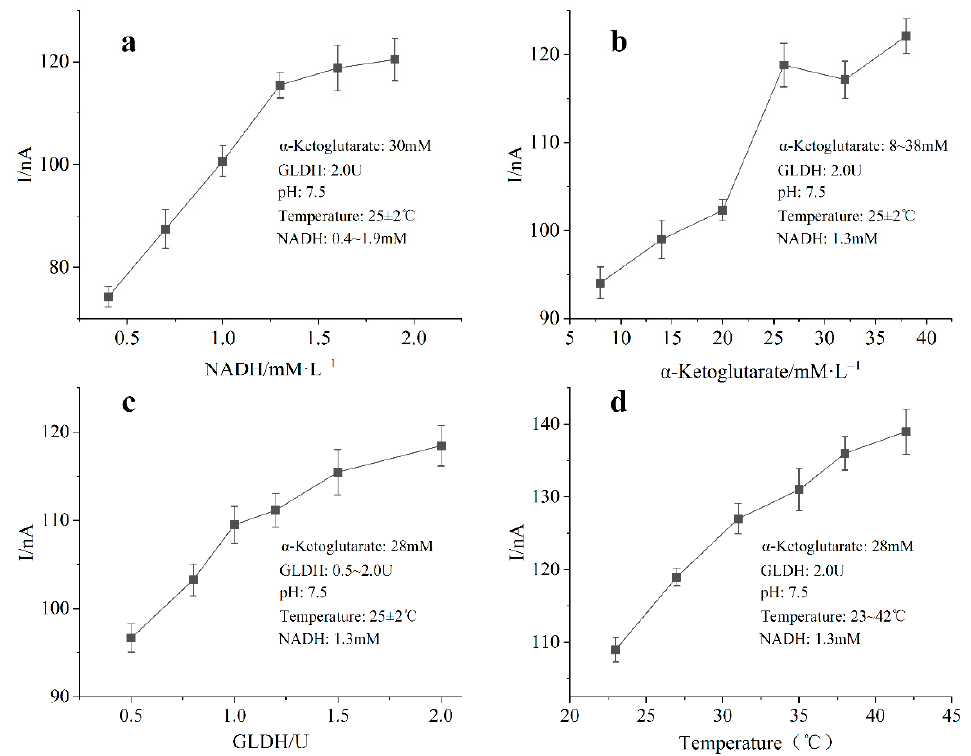
Figure 7. Graphs showing the response of the biosensor at different concentrations of NADH ( a ), α -Ketoglutarate ( b ) and GLDH ( c ); graphs showing the effect of temperature on the activity of bioreceptor, GLDH ( d ) ( n = 3).